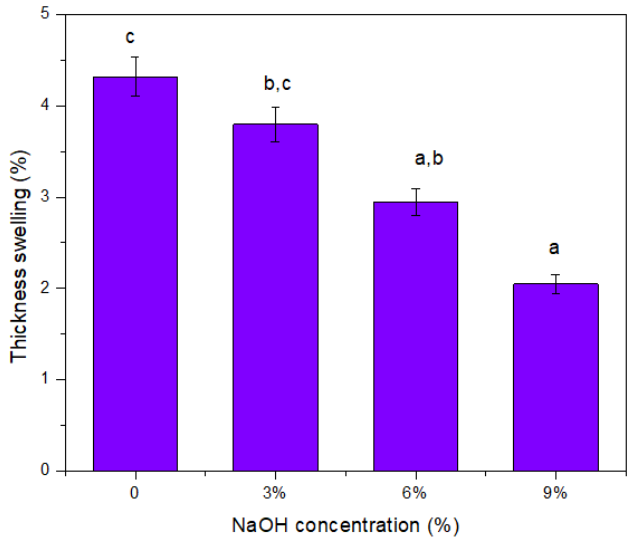
Figure 11. Thickness swelling of untreated and treated TPCS/PW/CCF composites. Letters a, b, and c is indicates the group of data for statistical analysis.